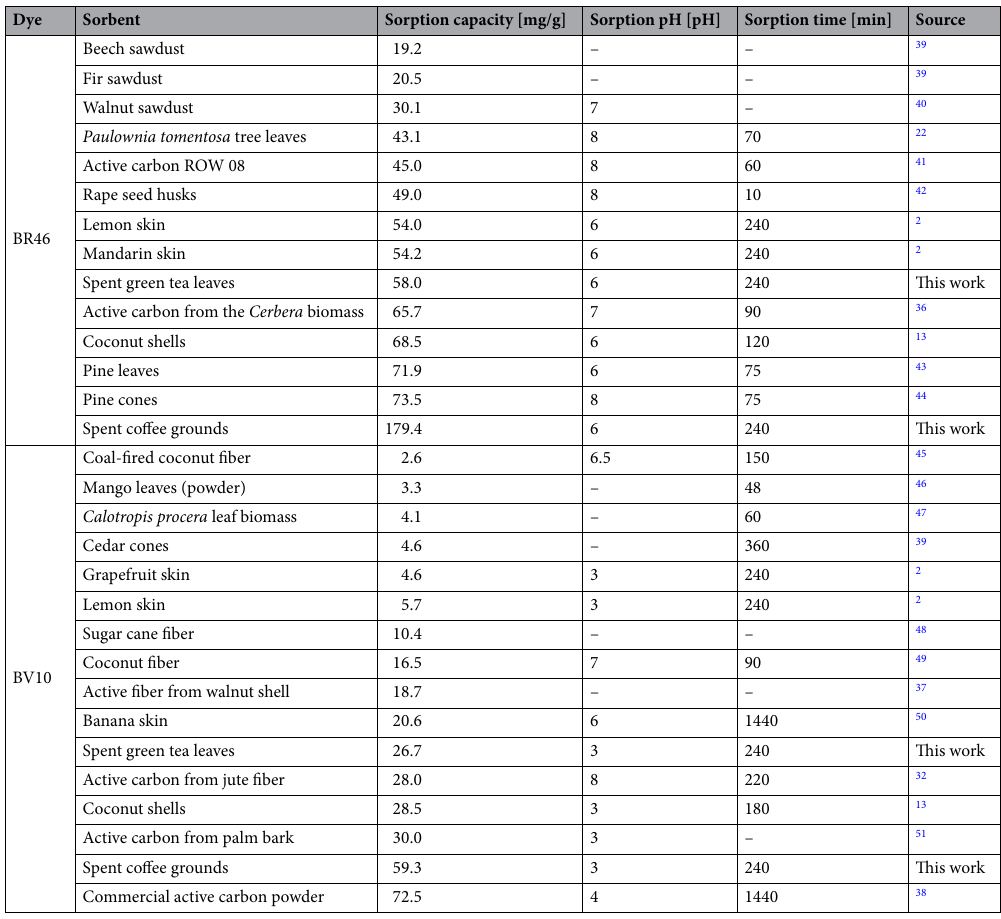
Table 5. Sorption capacity of various unconventional biosorbents and activated carbons towards BV10 and